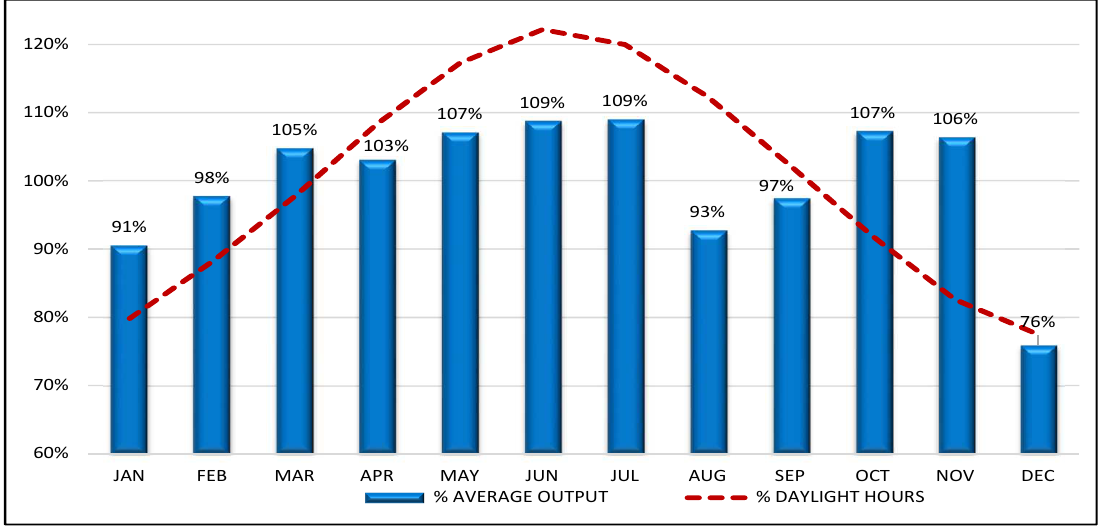
Fig. 4 Percentage of monthly mean output and percentage of monthly mean daylight. Source: own elaboration.